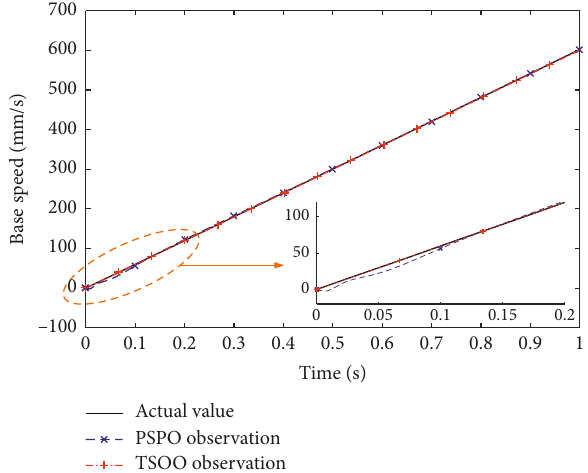
Figure 4: Observation effects of the TSOO and the PSPO on the base speed.